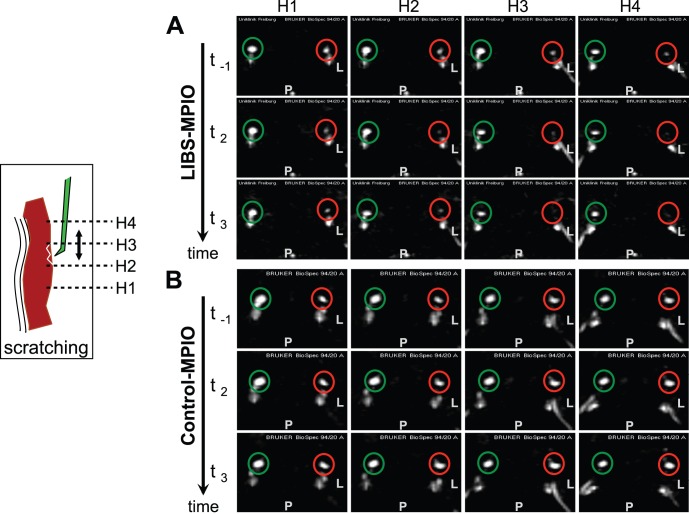
Axial MRI images of the external carotid arteries from two representative animals.Depicted are four consecutive slices (H1-H4) at three time points: t(−1) (before injection), t2 (16 minutes after injection) and t3 (24 minutes after injection). Red circles indicate the left external carotid artery which underwent surgery and scratching of the plaque, and green circles mark the contra lateral vessel. The animals orientation is indicated by labeling its posterior (P) and left (L) direction. Signal attenuation can be observed in the animal A which received LIBS-MPIO contrast agent whereas the blood signal remains hyperintense in animal B receiving the control-MPIO.